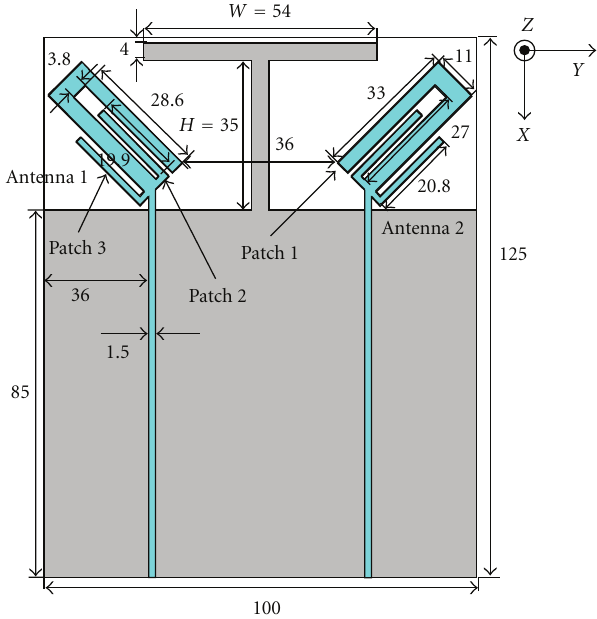
Figure 1: Geometry of the proposed multi-band MIMO antenna. (Unit: